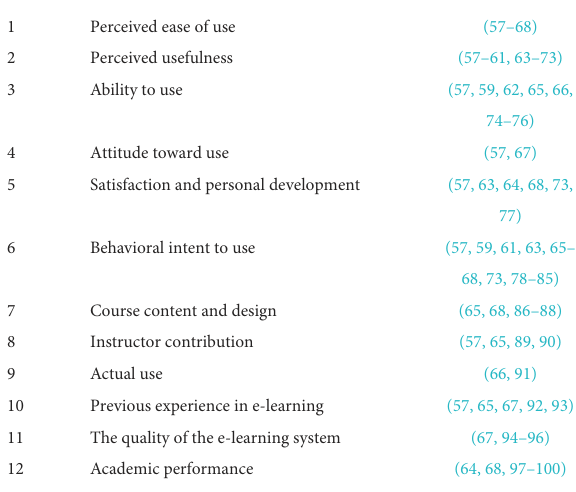
TABLE 1 Items selection based on the